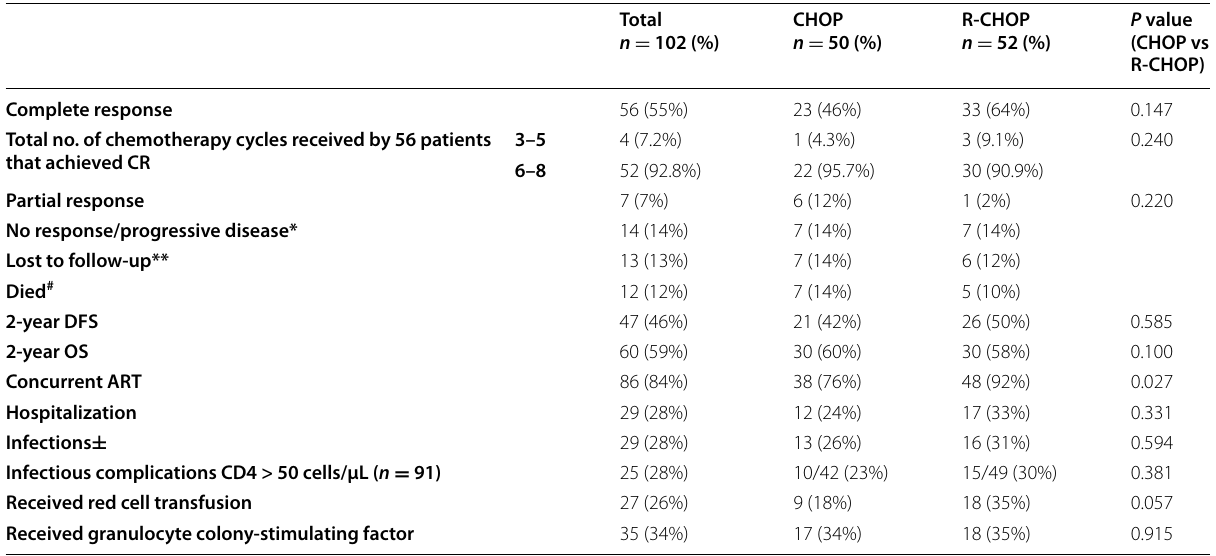
Table 2 Response to first‑line chemotherapy for patients with CD20‑positive HAL treated at King Edward VIII